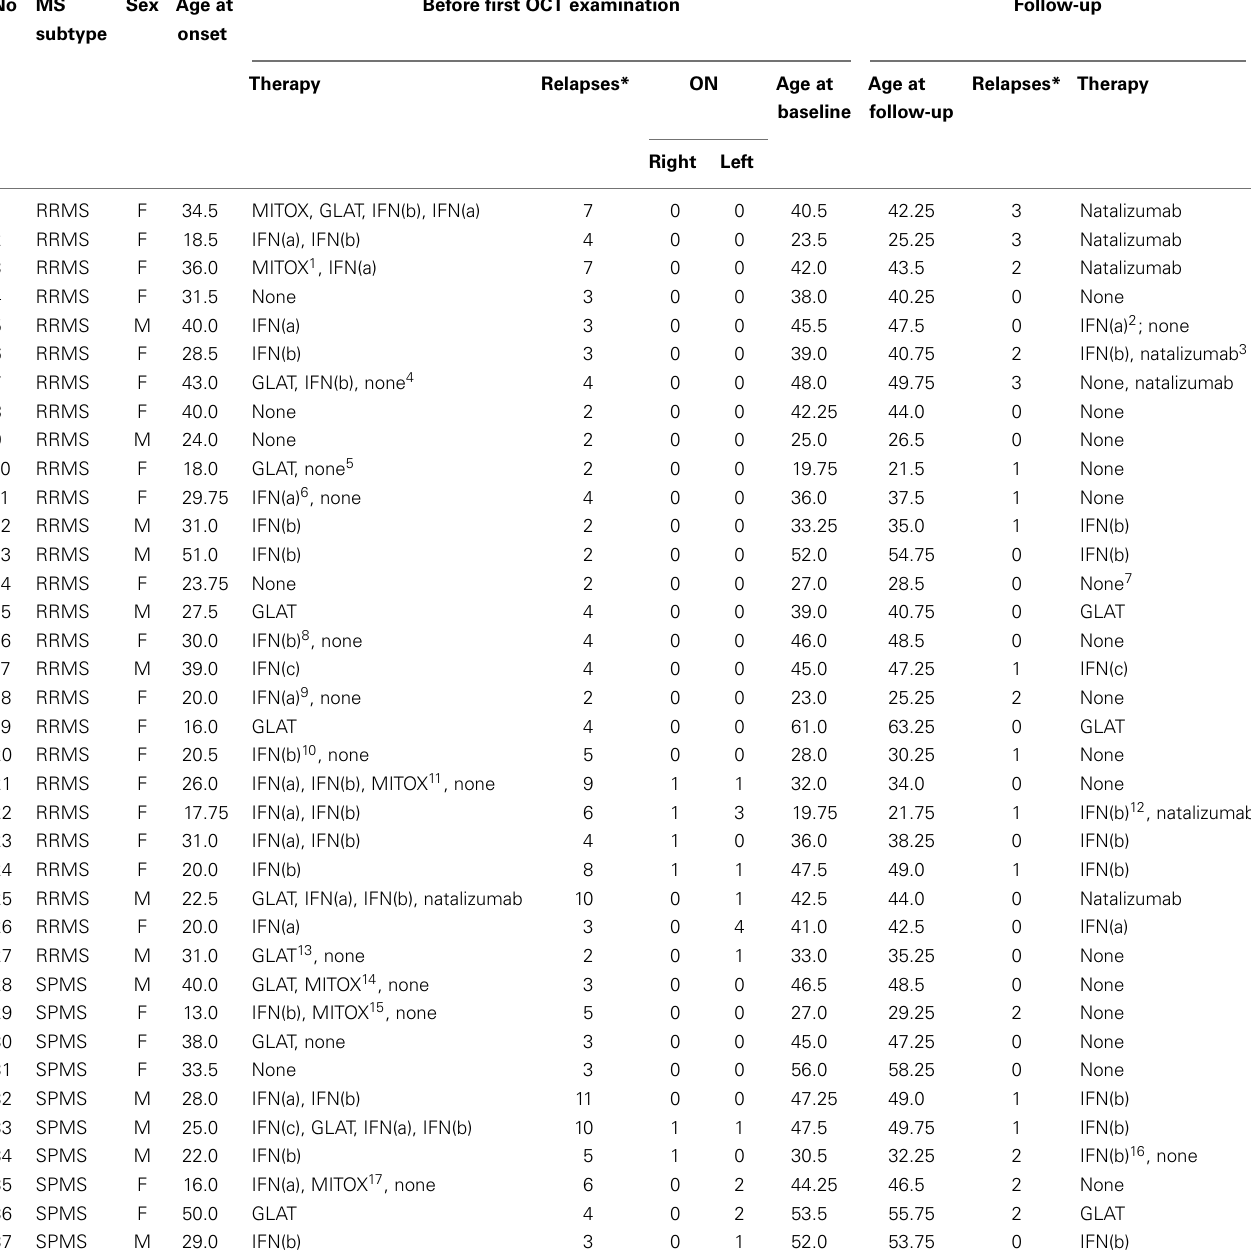
Table 1 | Summary of demographic and clinical